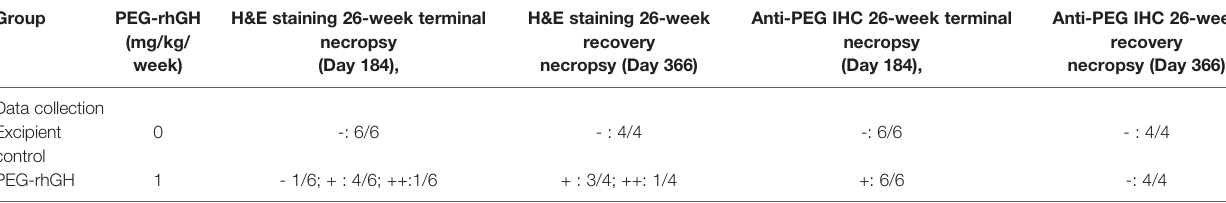
TABLE 2 | H&E staining and anti-PEG IHC staining counts of CP epithelium with 26-week administration and extra 26-week